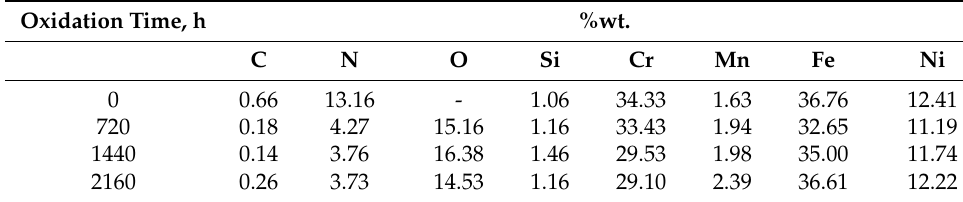
Table 3. Chemical composition for the unoxidized and oxidized in supercritical water CrN x -coated sample. Oxidation Time,